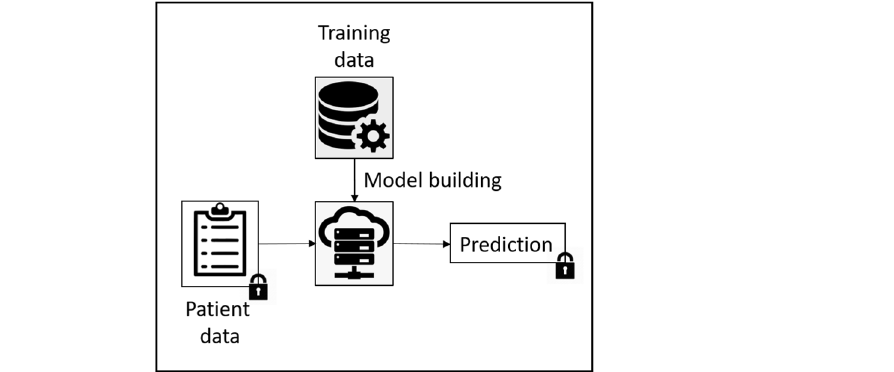
Figure 1. Our threat model for private